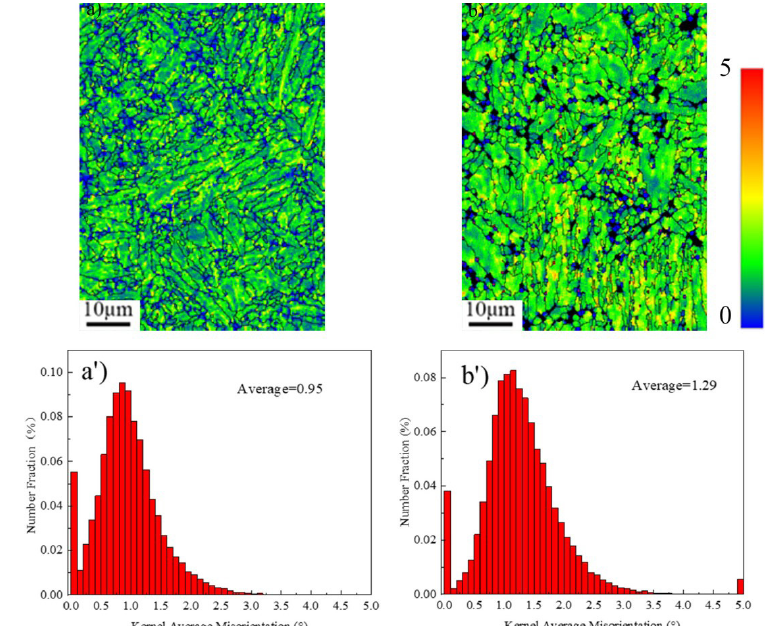
Figure 9. KAM histograms of samples before and after USRP treatment and their statistical plots: (a) and (a’) untreated specimens; (b) and (b’) USRP treated